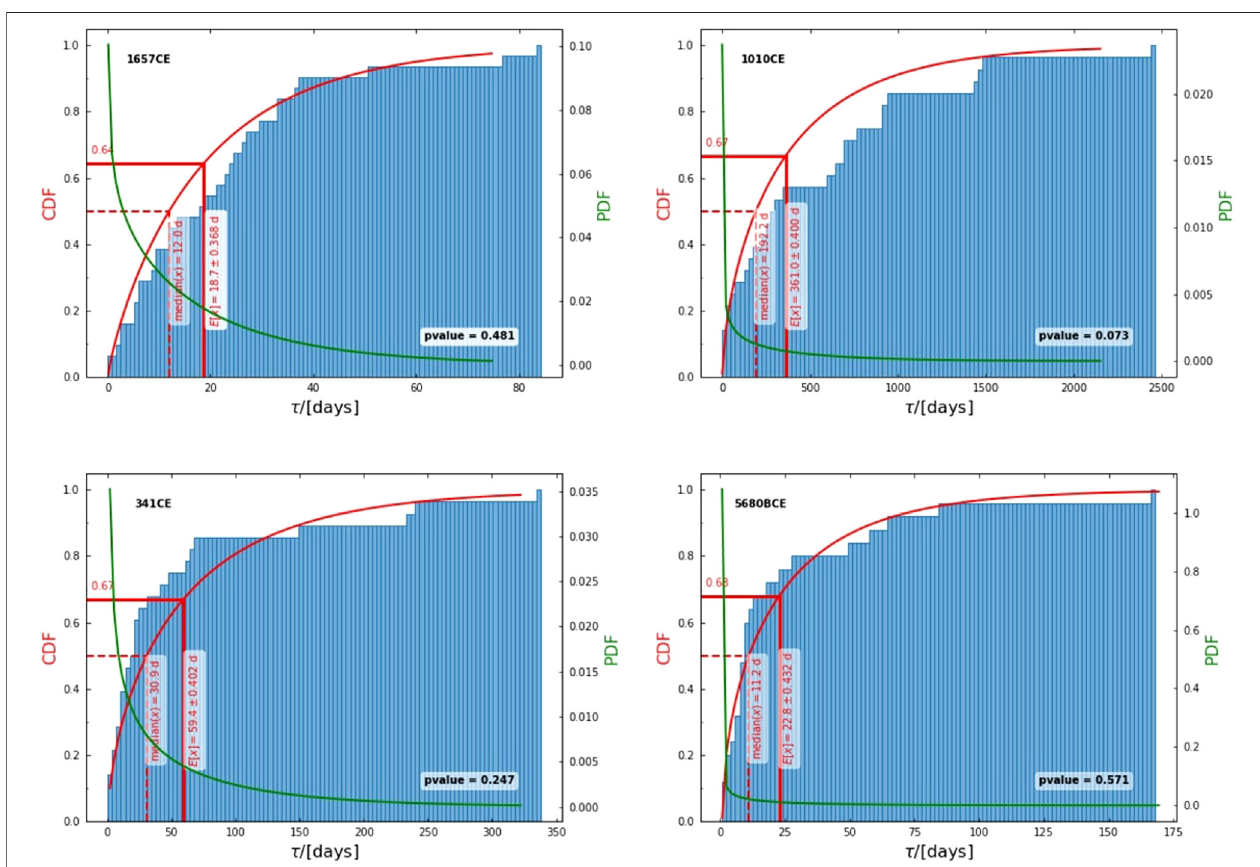
FIGURE 9 | Distribution of timescales for the 1657 Cal. CE, 1010 Cal. CE, ∼ 341 Cal CE and 5680 Cal. BCE eruptions. Blue bars indicate the empirical cumulative density frequencies (CDF), red curves indicate the theoretical distributions fi tted to these and the green curves represent the theoretical probability density frequencies. On each plot we indicate the mean and median timescales predicted by the theoretical distributions and the p -values (goodness-of- fi t) between model and data.